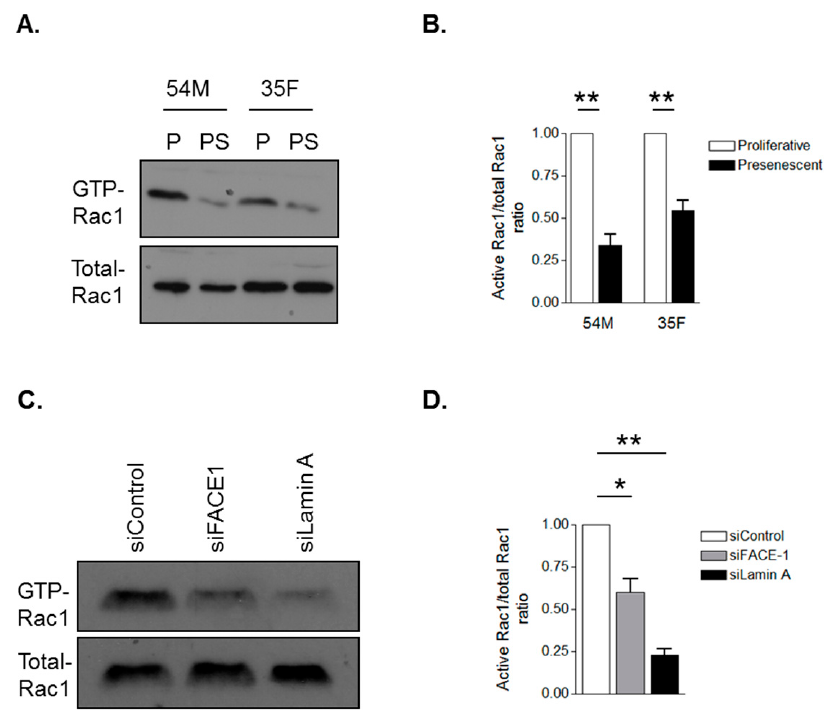
Figure 6. Prelamin A accumulation attenuates Rac1 activity. Glutathione-S-transferase (GST) pull-down assay using the GST-p21-associated protein-p21 Rho binding domain to precipitate GTP-bound Rac1 from ( A ) proliferative and presenescent 54M and 35F VSMCs and ( C ) control, FACE1- and lamin A/C-depleted VSMCs. Graphs show densitometry measurements of Active-Rac1/total-Rac1 ratios of ( B ) proliferative and presenescent VSMCs and ( D ) control, FACE-1- and lamin A/C-depleted VSMCs derived from three independent experiments (* p ≤ 0.05 and ** p ≤ 0.01).